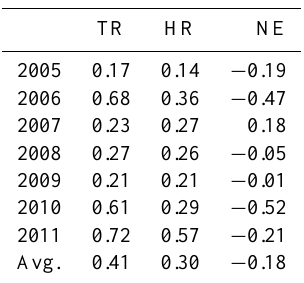
Table 3. Model performance of flood inundation extent and area compared with remote sensing. TR is the true ratio, HR is the hit ratio and NE is the normalized error (see Appendix A for their def-